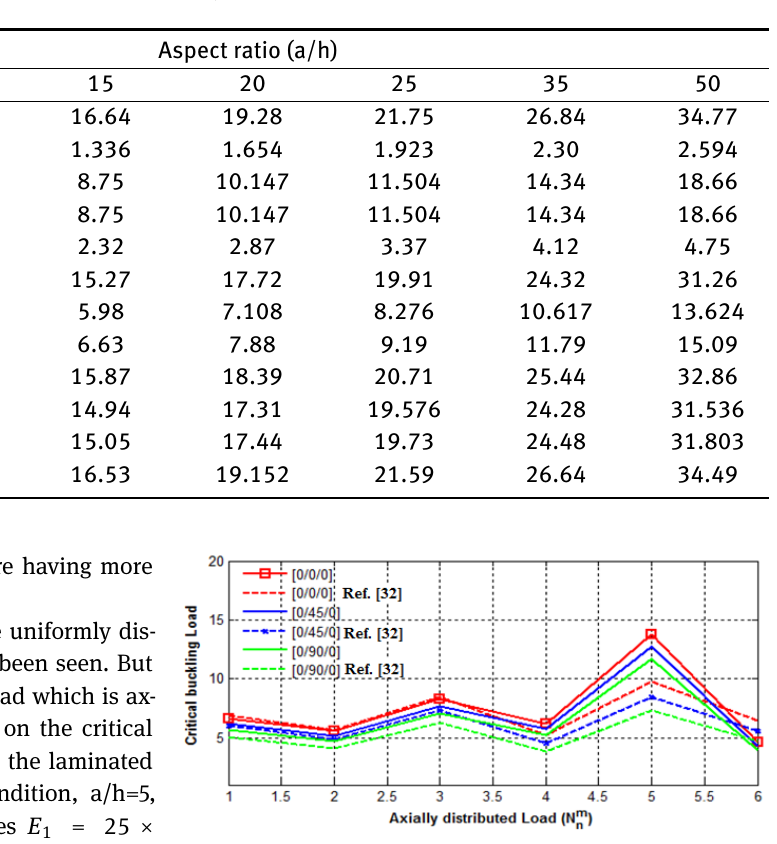
Figure 3: Effect of various axial in-plane loads over the dimension- less critical buckling load for laminated composite beam